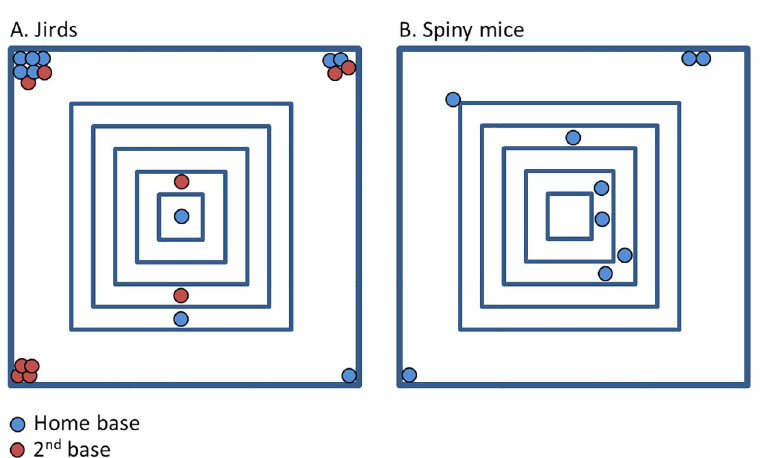
Fig 6. The location of home-bases and secondary bases in jirds (A) and spiny mice (B). As shown, jirds established eight home-bases on the arena floor (blue circles) and two home-bases on the pyramid. In addition, they establish eight second-bases (red circles) on the arena floor and two on the pyramid. Spiny mice (B) established five home-bases on the pyramid, one home-base on the floor next to the pyramid, and three home-bases on the arena floor (spiny mice did not establish secondary